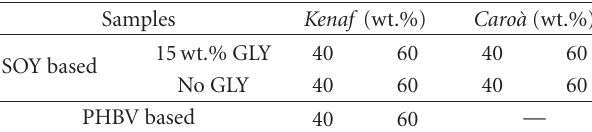
Table 1: Ecocomposites